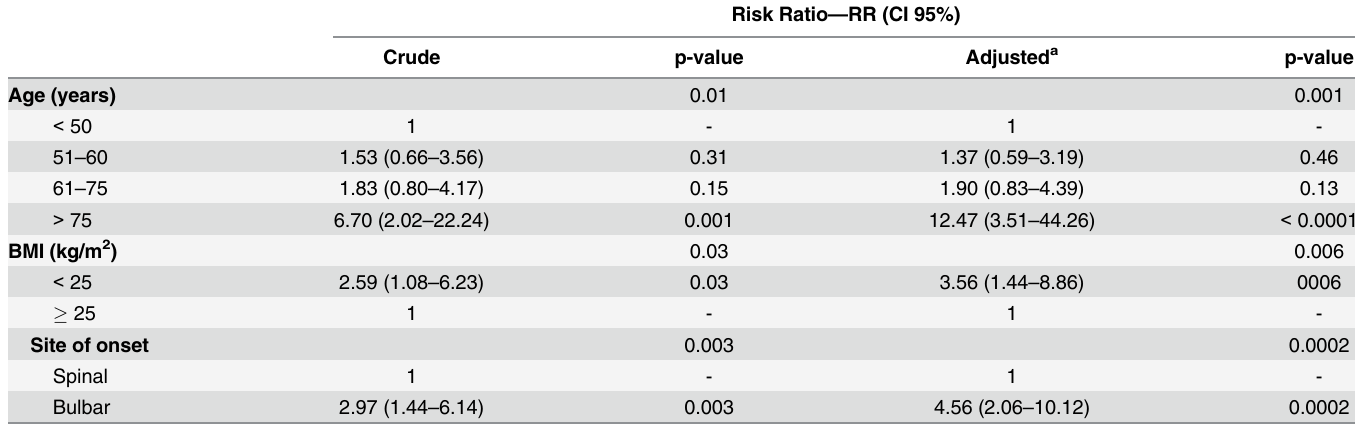
Table 3. Crude and adjusted Risk Ratio for survival, by demographic and selected clinical variables and adjusted a by age, BMI and site of